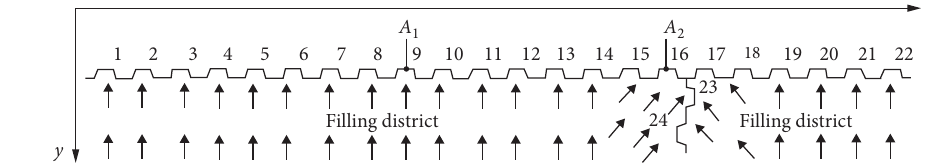
Figure 14: Lateral pressure distribution.